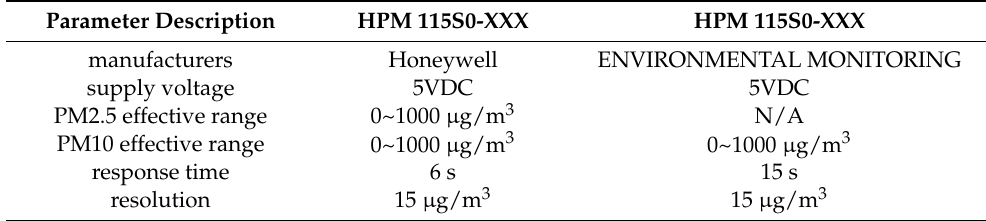
Table 2. Comparison of particulate matter sensors.